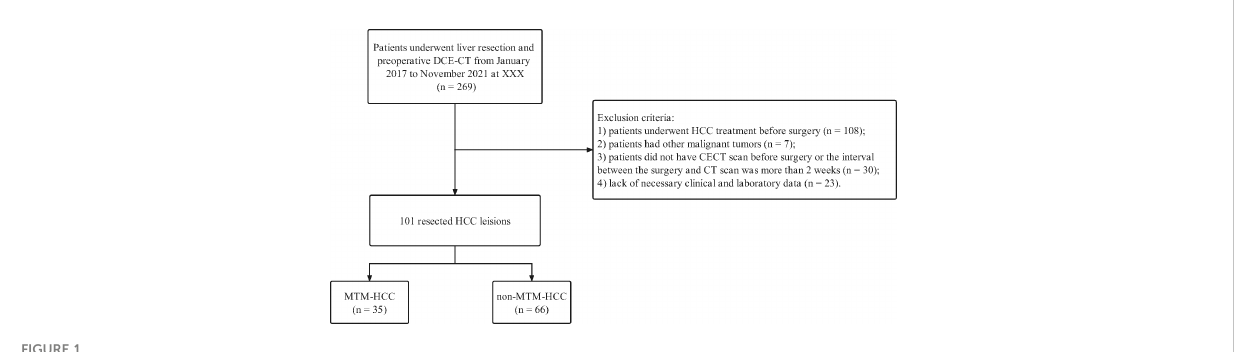
FIGURE 1 Flowchart of this retrospective